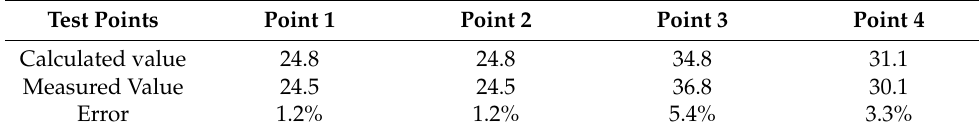
Table 13. Error between calculated and measured